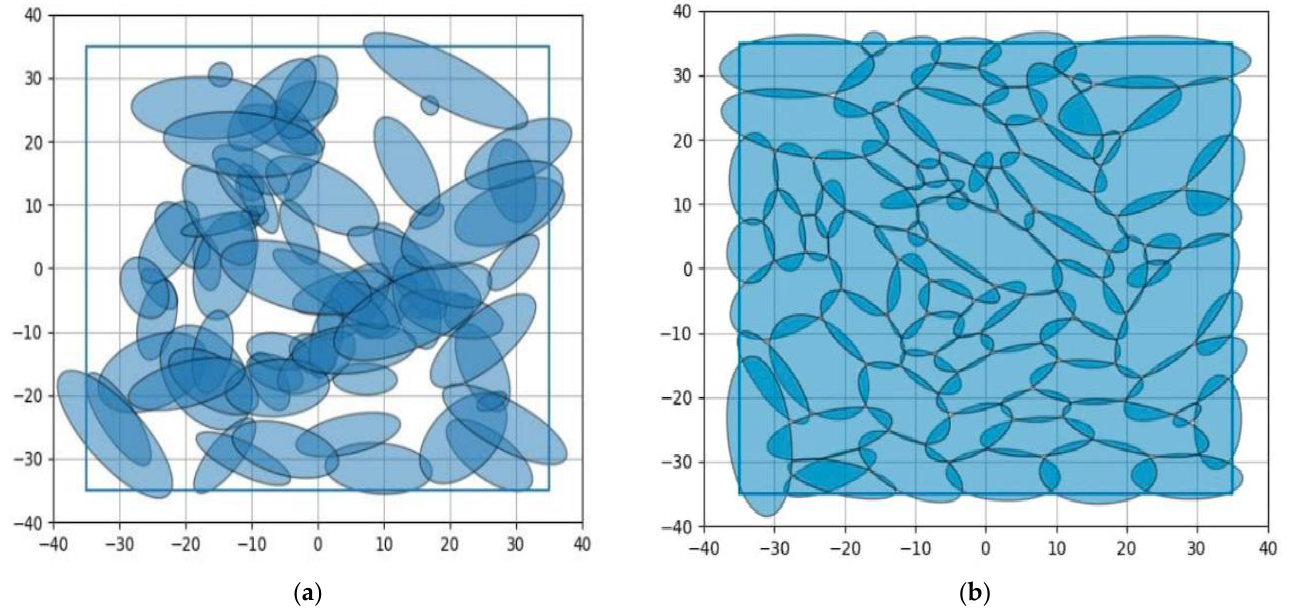
Figure 6. The continuous MCLP of 75 ellipses: ( a ) starting point and ( b ) local optimum.